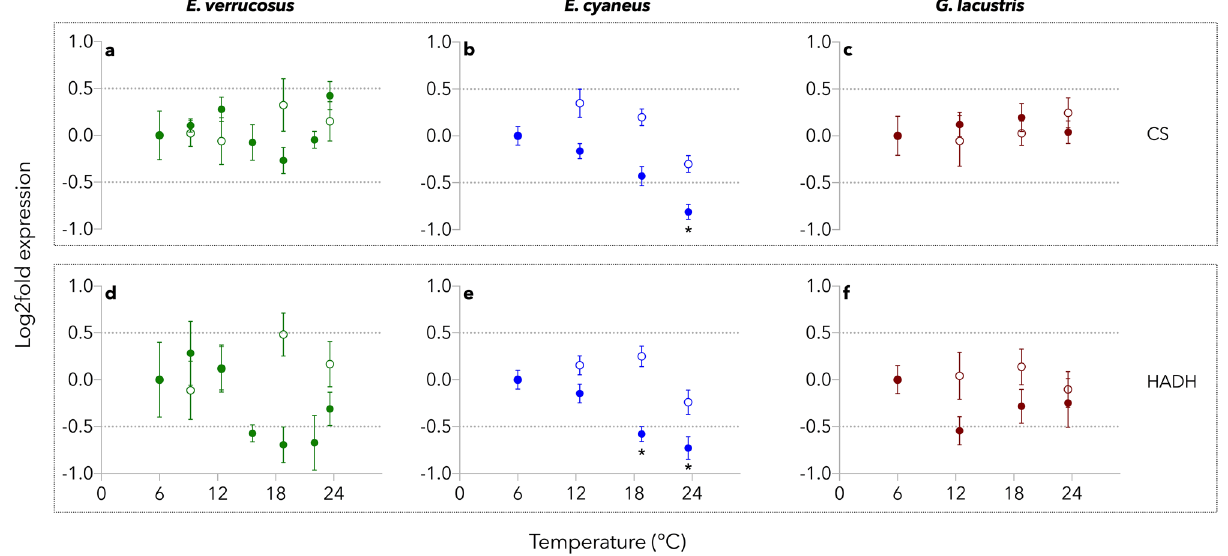
Figure 4. Temperature-dependent expression of RNA transcripts of key metabolic enzymes. Transcripts of citrate synthase (CS) and 3-hydroxyacyl-CoA dehydrogenase (HADH) were analyzed in whole animal extracts of E. verrucosus , E. cyaneus , and G. lacustris upon exposure of the animals to gradual temperature increase (0.8 °C d −1 ). Samples of all three species were taken at 6 °C, 12.4 °C, 18.8 °C, and 23.6 °C; besides, samples of E. verrucosus were taken at 9.2 °C, 15.6 °C, and 22 °C. Expression data are expressed as log2fold change calculated against the same endogenous controls ( actin and gapdh ) for all three species. Temperature-treated groups are shown with filled circles, whereas the time control groups (kept at 6 °C) are represented by open circles. Asterisks indicate data points outside the range of biological insignificance (± 0.5 log2fold change; dotted horizontal lines), which are significantly different from the 6 °C treatment group (ANOVA, p < 0.05). Data are presented as means ± s.e.m. (n = 5–7).